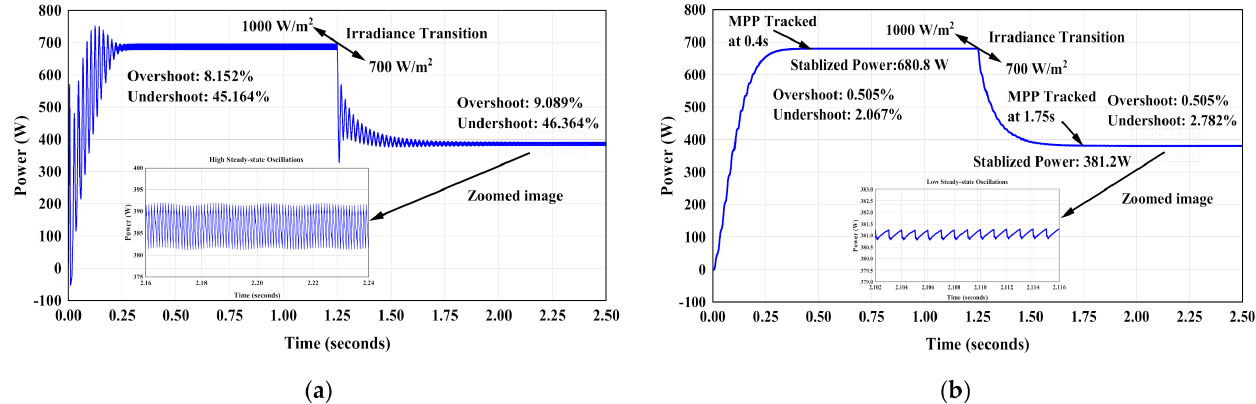
Figure 10. Power characteristics during irradiance transition (STC → UI-1), ( a ) high oscillations, and ( b ) low